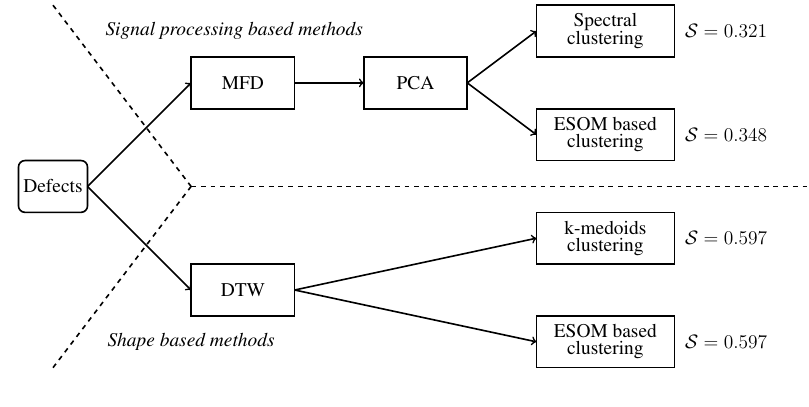
Figure 9. Algorithm